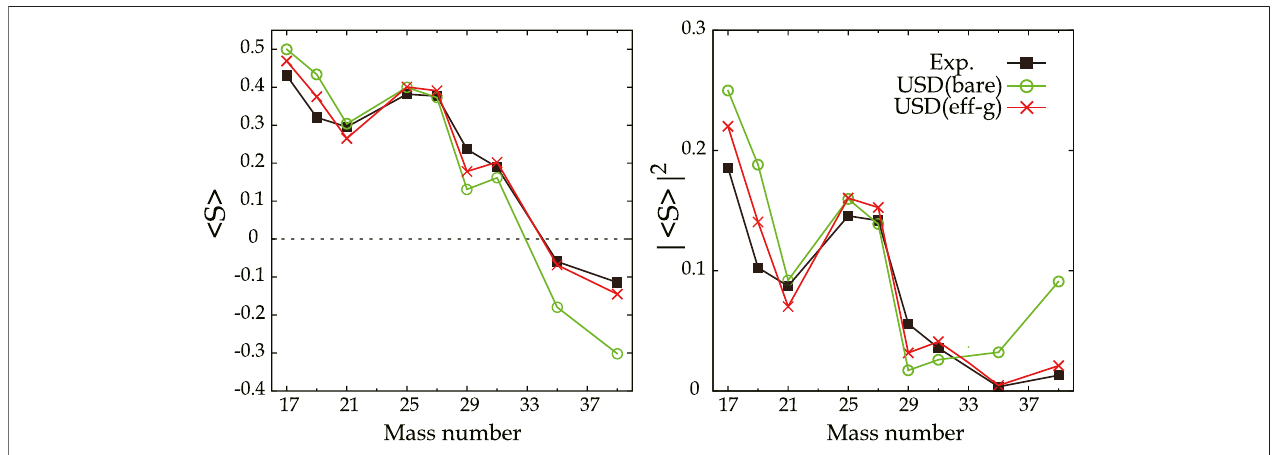
FIGURE 9 | The diagonal spin matrix element 〈 S 〉 obtained from the IS magnetic moments of mirror nuclei in the sd-shell region. The data were taken and calculated from Brown and Wildenthal (1983), Brown and Wildenthal (1987). The lines are for guiding the viewer ’ s